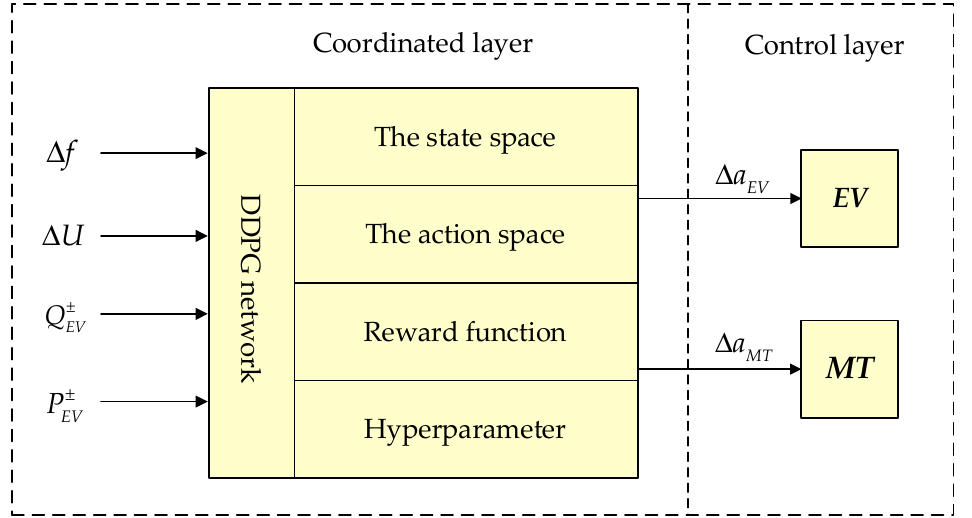
Figure 6. Microgrid LFC controller structure based on DDPG.